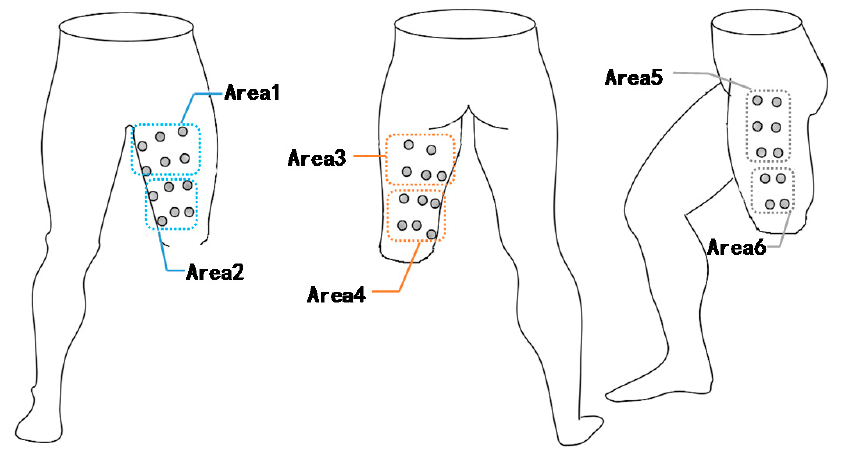
Figure 9. The surface of the residual limb is divided into six areas. The standard for distinguishing the areas is the distance from the wound. Area 1 and Area 2 are on the front, Area 3 and Area 4 are on the back, and Area 5 and Area 6 are on the outer side.